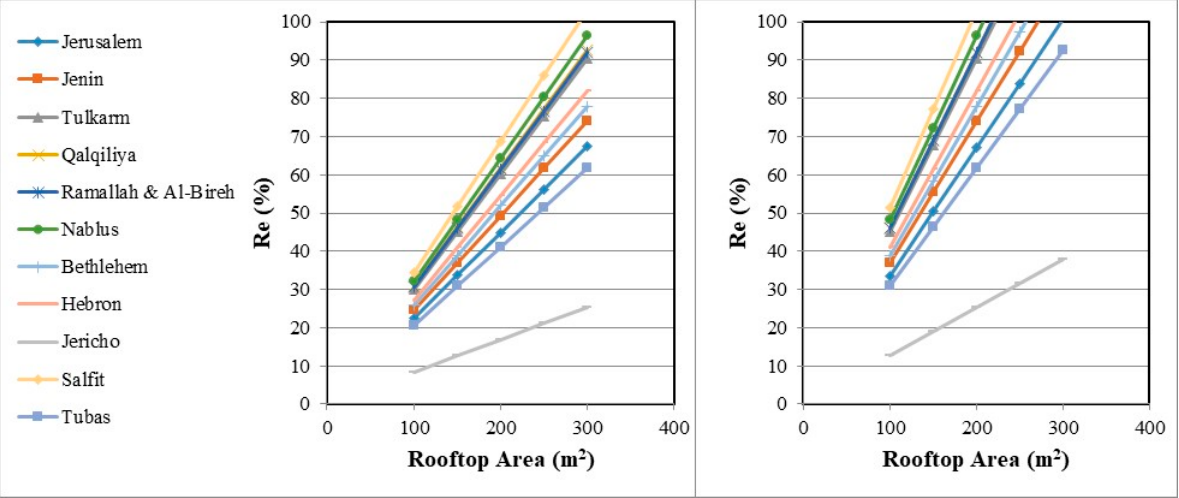
Figure 6. Re percentages of different West Bank governorates for the different rooftop areas for a monthly DWDv of 13 m 3 /family. S1 ( left ); S2 ( right ).